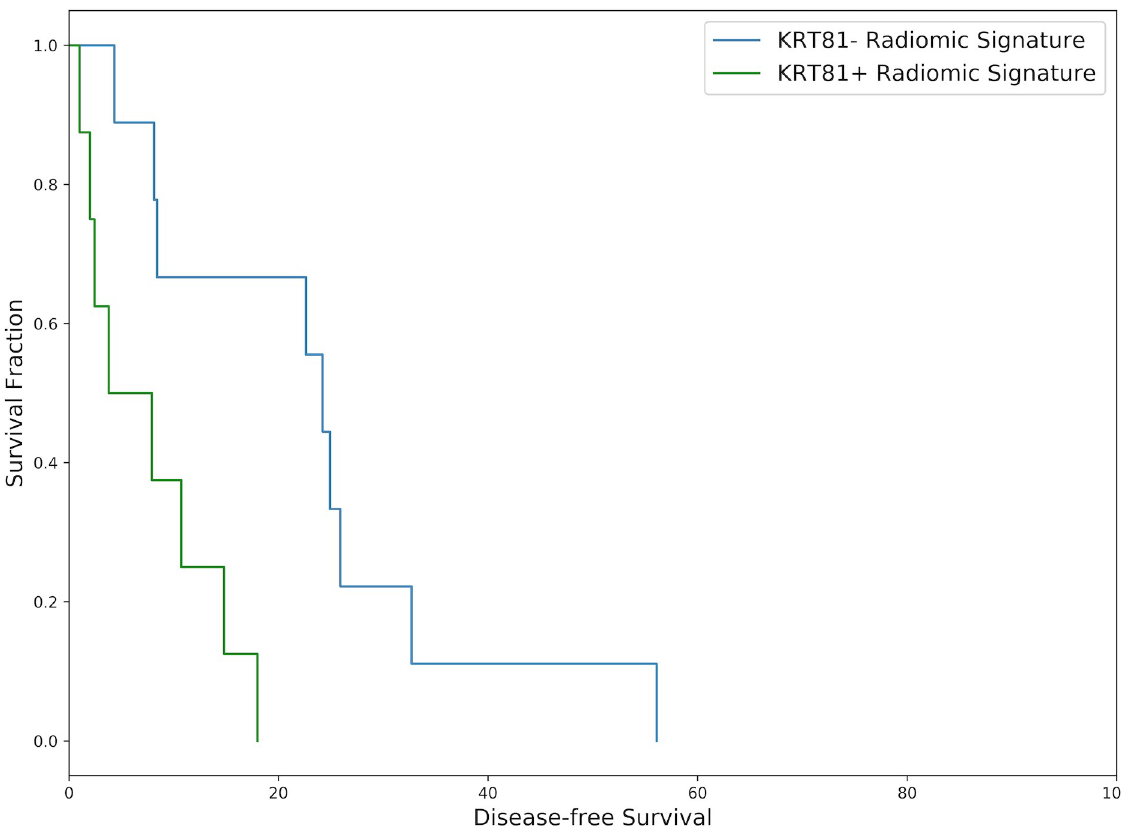
Fig 4. Exemplary Kaplan-Meier disease-free survival curve drawn from the 10 cross-validation folds representing the median hazard ratio. Patients with a high risk radiomic phenotype experienced significantly diminished survival (7.90 vs. 24.20 months median DFS, log- rank-test p = 0.004, HR = 3.17, N =